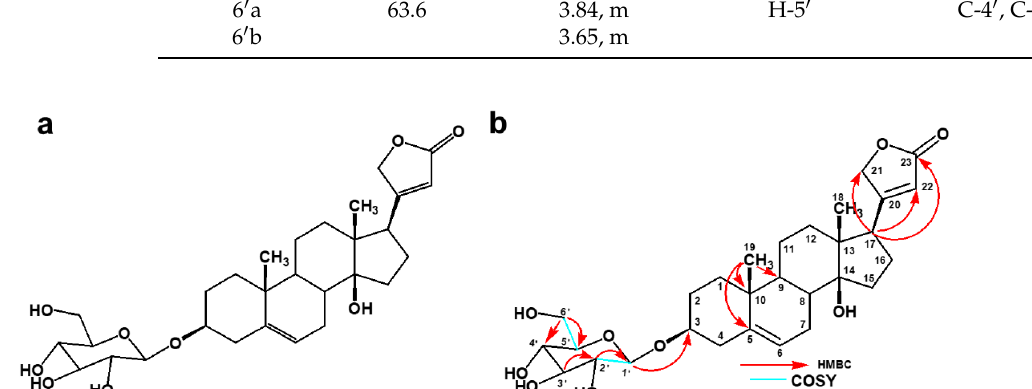
( b ) Figure 5. Changes in the level of A β 42, following exposure to ( a ) compound 1 and ( b ) compound 2 in vitro. Cells were incubated with indicated concentrations of compounds for 8 h. Statistically significant differences in % of inhibition values are indicated (*** p < 0.001, one-way ANOVA). Data are presented as mean ± SEM ( n = 4). DMSO served as negative control.